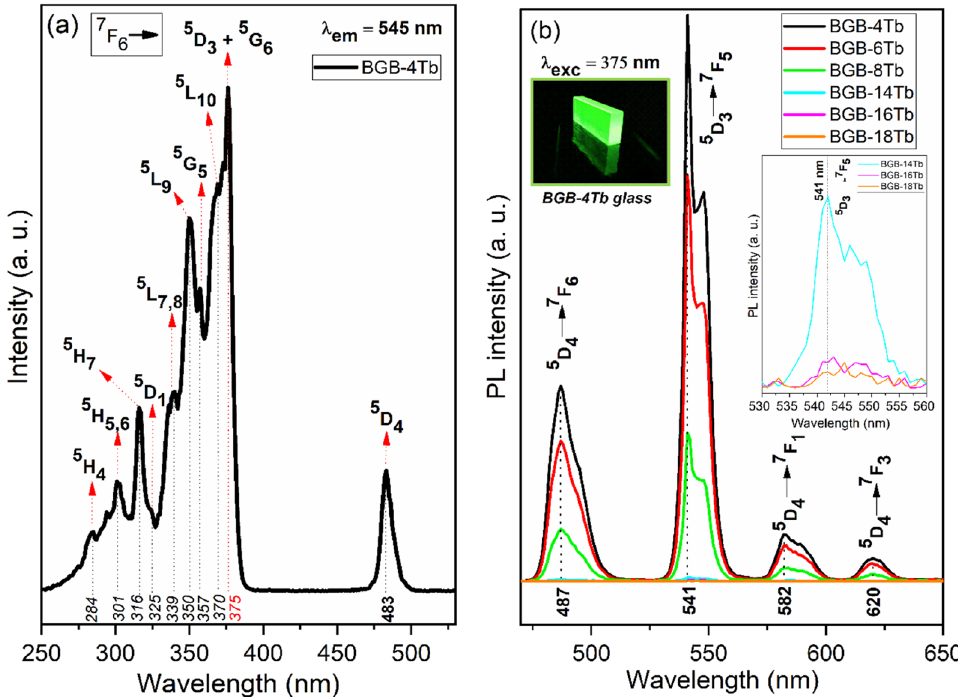
Figure 7. ( a ) PLE spectrum of the BGB-4Tb glass and ( b ) PL spectra of the BGB- x Tb glasses at room temperature. Inset photograph: BGB-4Tb sample under excitation at 375 nm. Inset: PL spectra of the BGB- x Tb glasses ( x = 14, 16, and 18 mol% Tb 4 O 7 ) in the region from 530 to 560